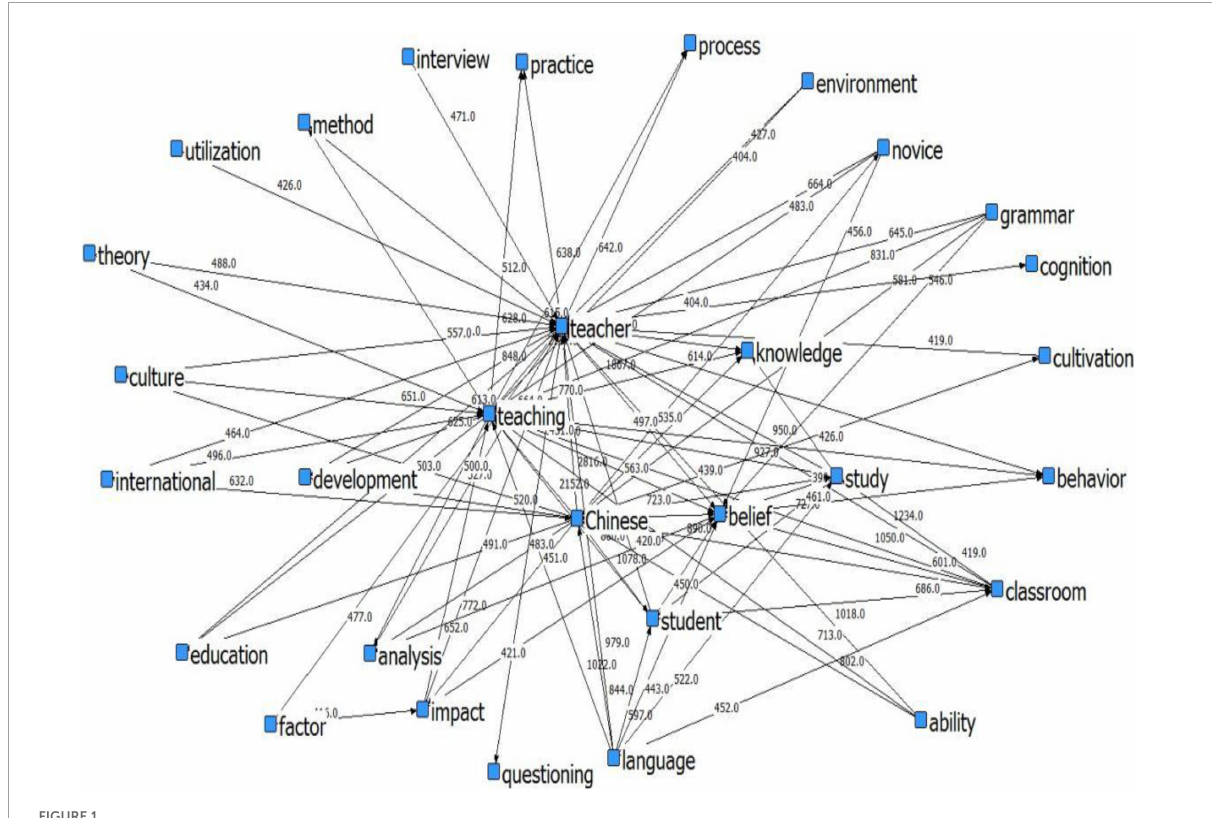
FIGURE1 Semantic network of high frequency